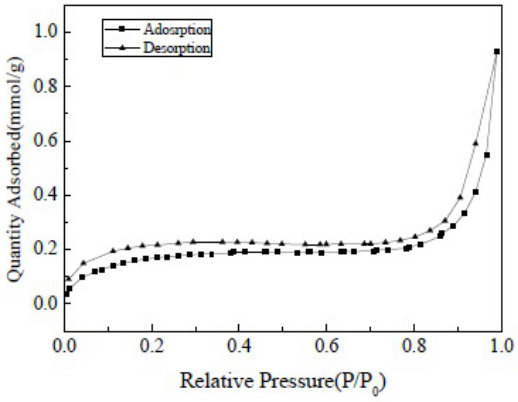
Figure 7: The N2 adsorption-desorption isotherm of the HPRs